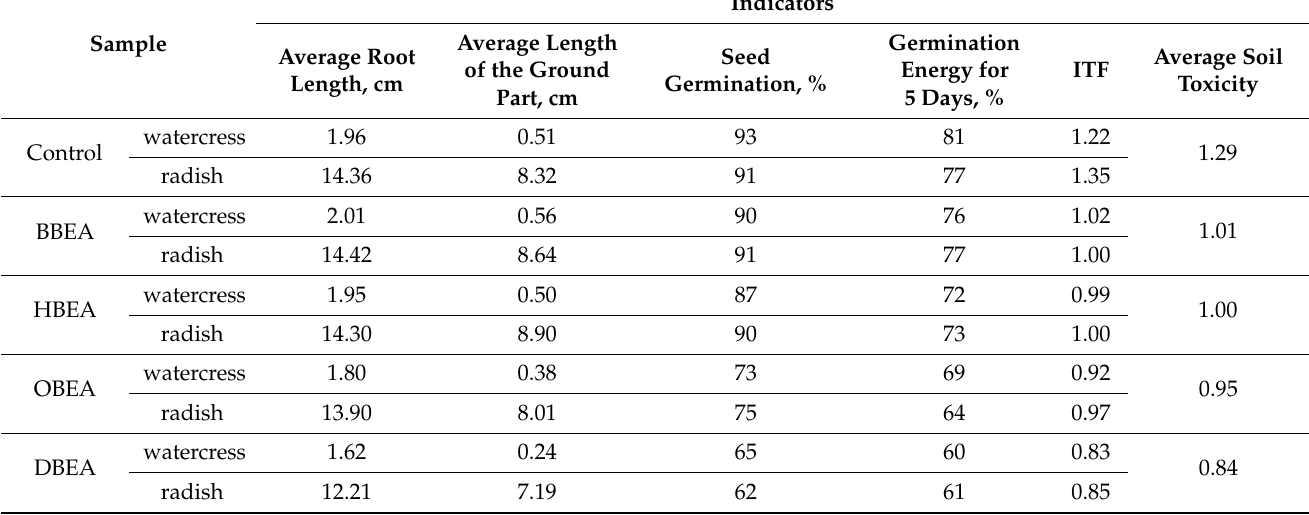
Table 3. Results of determining the phytotoxicity of alkyl butoxyethyl adipates.